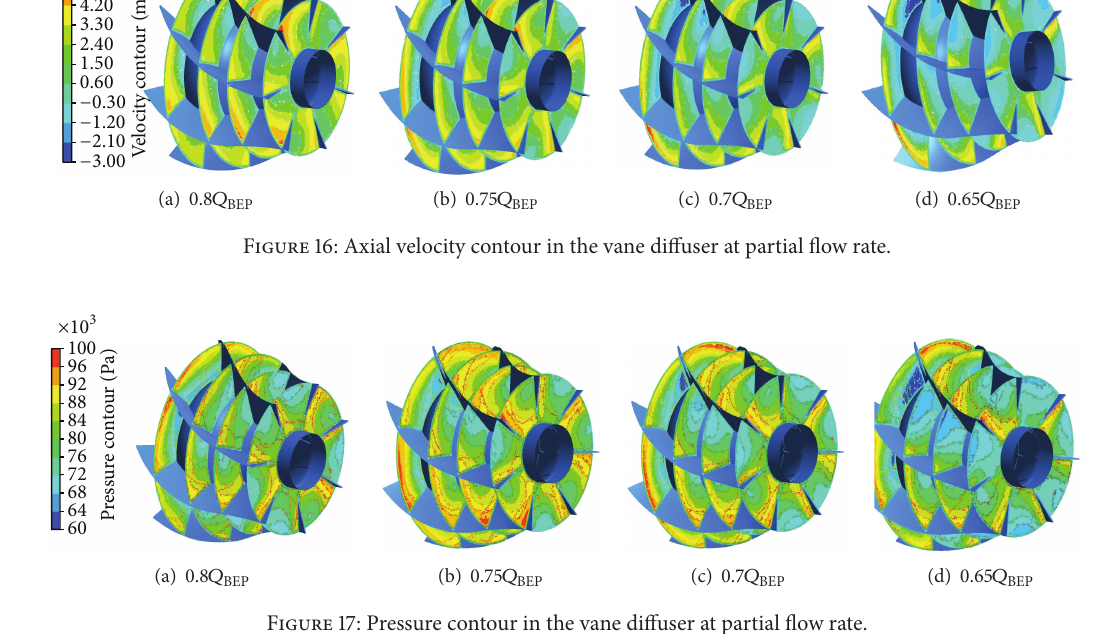
Figure 17: Pressure contour in the vane diffuser at partial flow